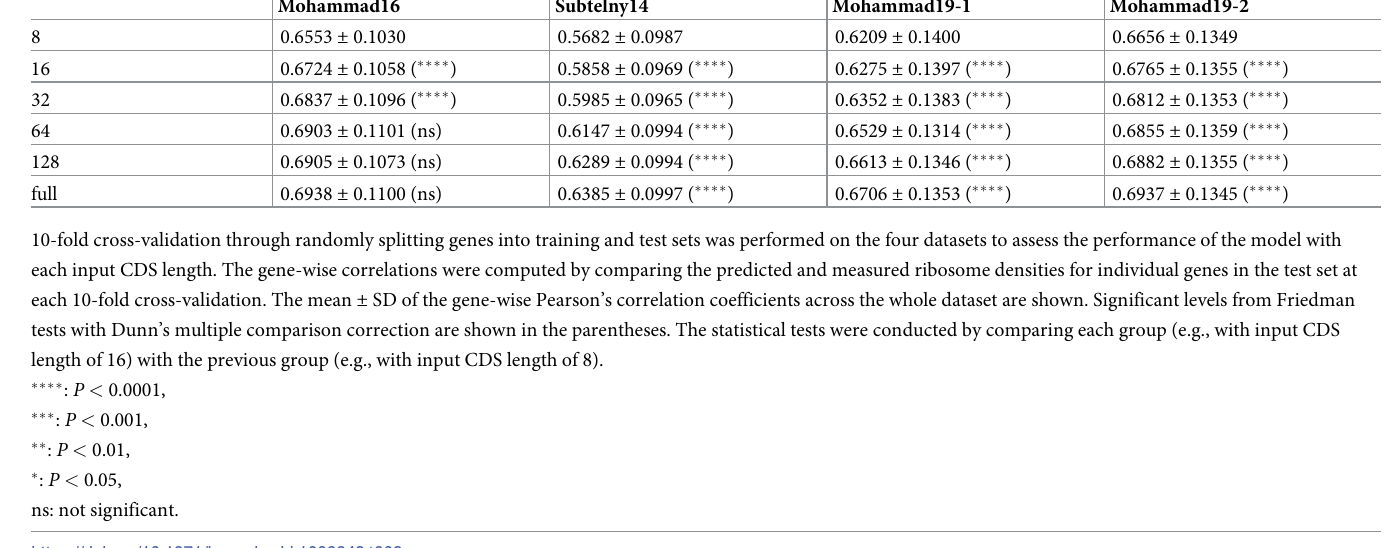
Table 2. Performance evaluation of RiboMIMO with different CDS lengths as input, measured in terms of Pearson’s correlation coefficient. Input CDS length